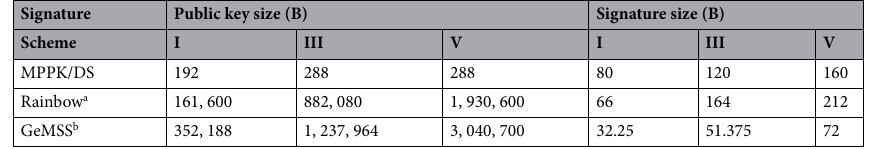
Table 5. Public Key Sizes of the the MPPK/DS scheme as well as the NIST PQC Round 3 multivariate DS schemes, with values given in Bytes. a The rainbow1aclassic363232 primitive was measured for Level I, rainbow3cclassic683248 for Level III, and rainbow5cclassic963664 for Level V. b GeMSS128 primitive corresponds to values for level I, GeMSS192 corresponds to values for level III, and GeMSS256 corresponds to values for level V.